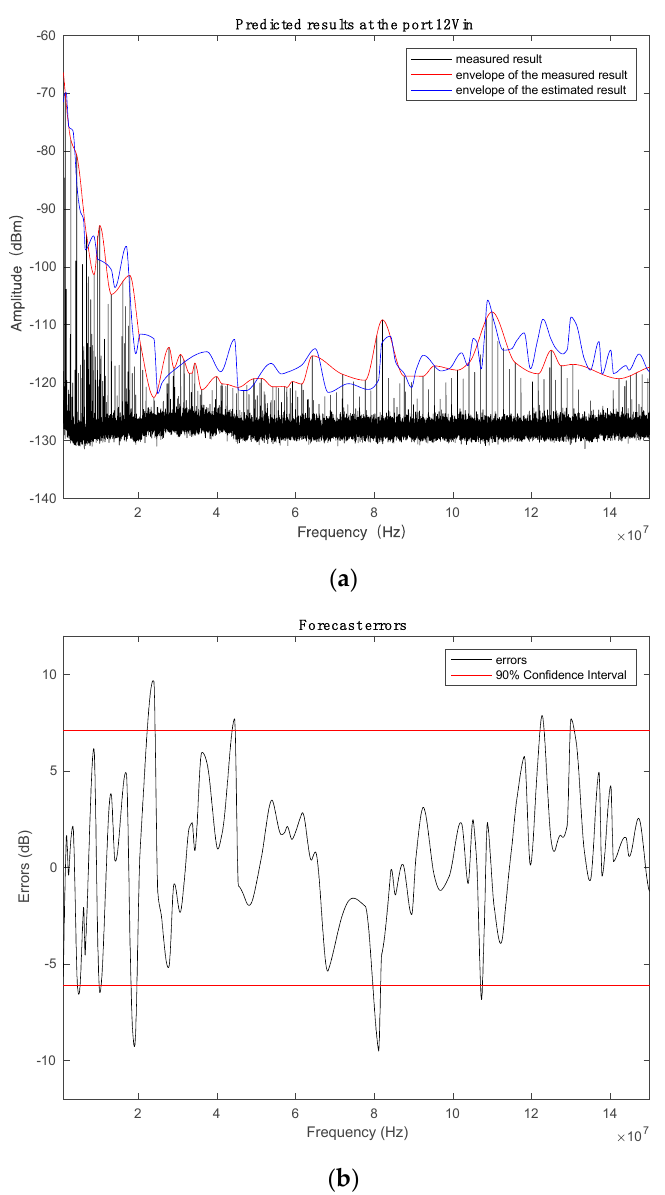
Figure 21. Comparison between the measured result and the estimated one. ( a ) Predicted results; ( b ) forecast errors.